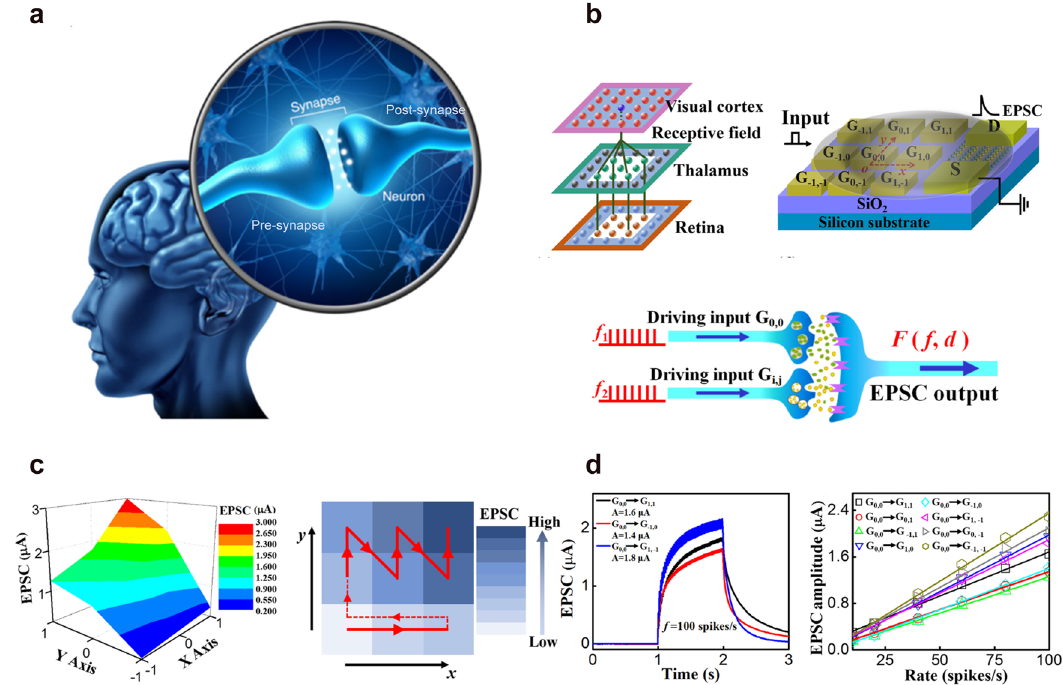
Fig. 7 The scheme and functions of multi-synapse. a Schematic illustration of a Biological network. Reproduced with permission 25 . Copyright 2020, Springer Nature. b Schematic picture of the visual system and 2D MoS 2 neuromorphic transistor with a grid of 3 × 3 coplanar- gate arrays. Reproduced with permission 116 . Copyright 2018, American Chemical Society. c , d 2D EPSCs surface summarized as a function of spatial coordinate, and each gate has a different coordinate. EPSC responses driven by dual spike inputs and its different orientation